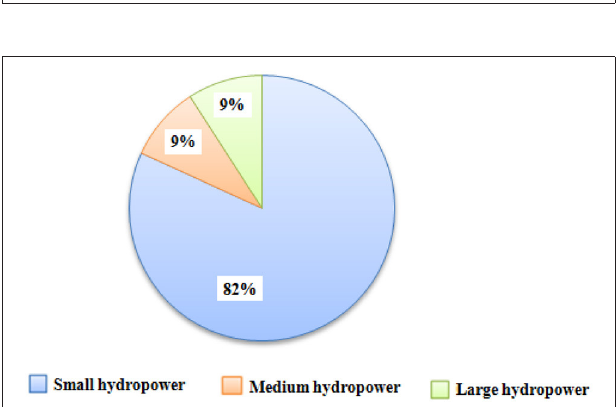
FIGURE 13 | Classification of the exploitable hydropower potential sites by the production capacity.